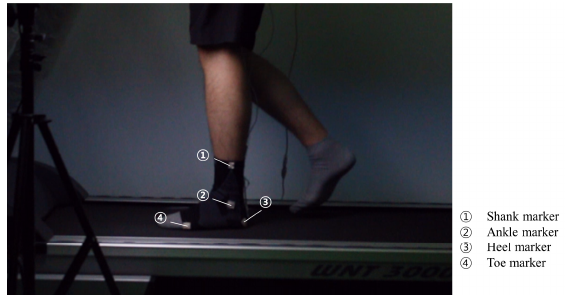
Figure 6. Subject walking on the treadmill with a marked brace.